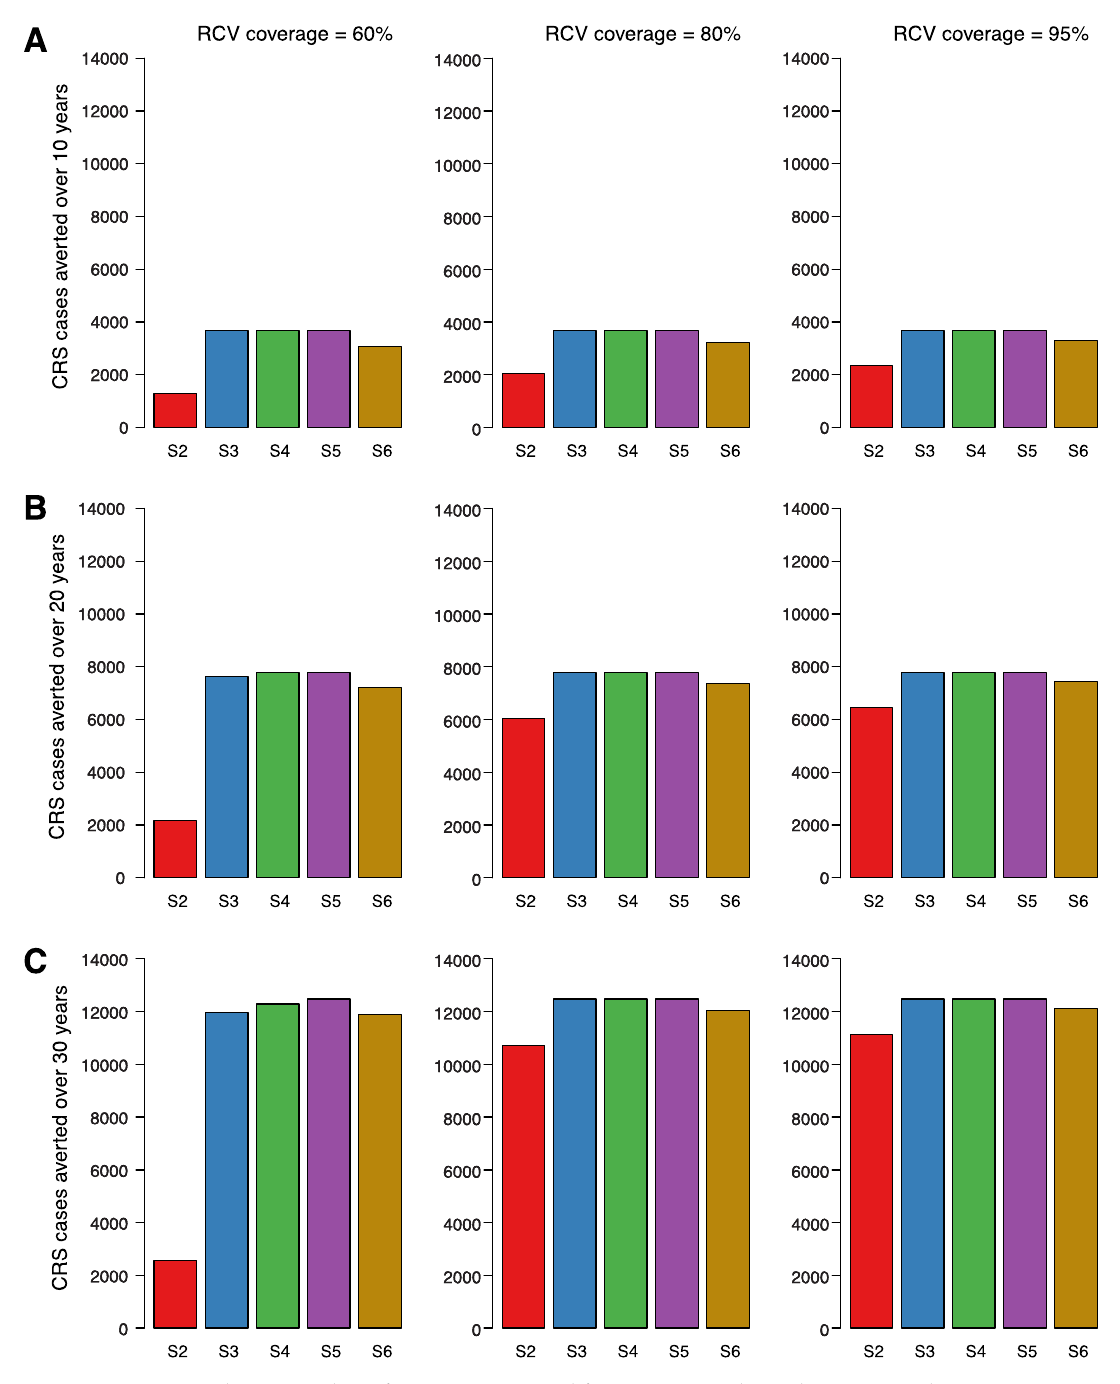
Figure 3. Cumulative number of CRS cases averted for scenarios 2 through 6 compared to scenario 1 over three time horizons post vaccine introduction. Each row of figures represents a di ff erent time horizon; 10 years ( A ), 20 years ( B ), and 30 years ( C ). Each column represents a di ff erent level of vaccination coverage for routine doses (60%, 80%, and 95%) from left to right, while maintaining coverage at 80% for vaccines administered outside the routine schedule. Scenarios 2 through 6 were each compared to scenario 1 and represent the bars in each plot (S2 = scenario 2 vs. scenario 1, S3 = scenario 3 vs. scenario 1, S4 = scenario 4 vs. scenario 1, S5 = scenario 5 vs. scenario 1, S6 = scenario 6 vs. scenario